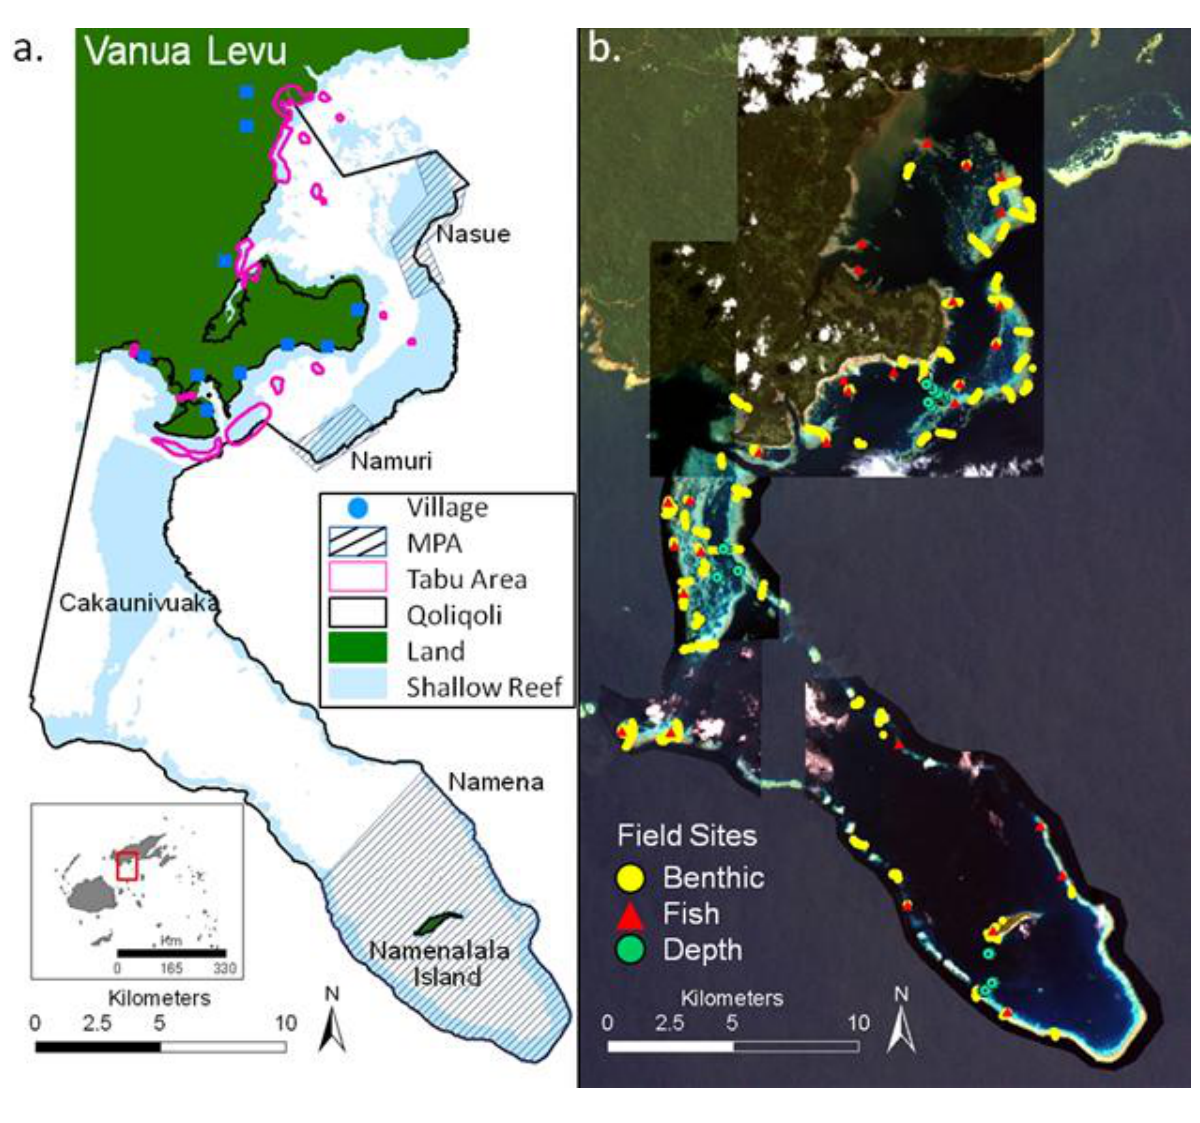
Figure 1. Overview of Kubulau fisheries management area (qoliqoli). (a ) shows the boundary of the management area, as well as its traditional village-managed tabu areas (pink outline) and district-managed marine protected areas (diagonal lines, names next to areas). Inset illustrates location within Fiji. ( b ) shows the extent of the Landsat TM data (background) and IKONOS/Quickbird data (foreground), as well as sites where benthic, fish and depth data were